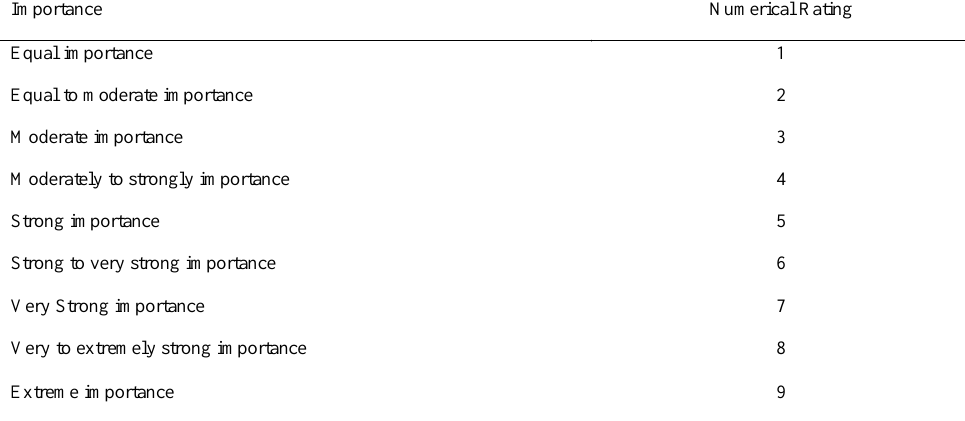
Table 2: comparison of criteria for scale (Çimren et al .,